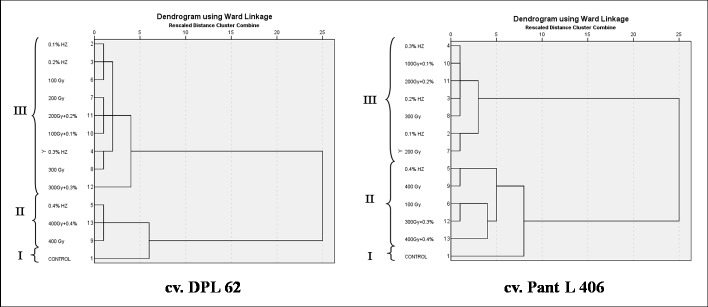
Dendrogram of lentil population clustering based on ten quantitative traits.